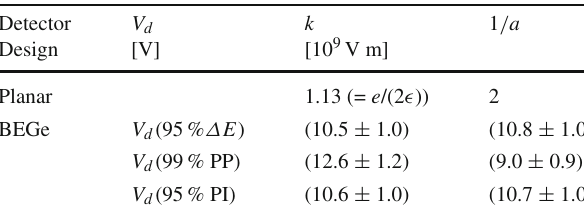
Table 2 Dependence of the full depletion voltage on detector parame- ters following Eq. (3). The best parameters of the linear fit are